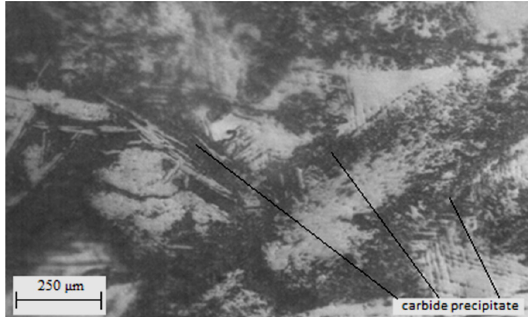
Figure 8. Optical micrograph of sample of failed crusher jaw (F